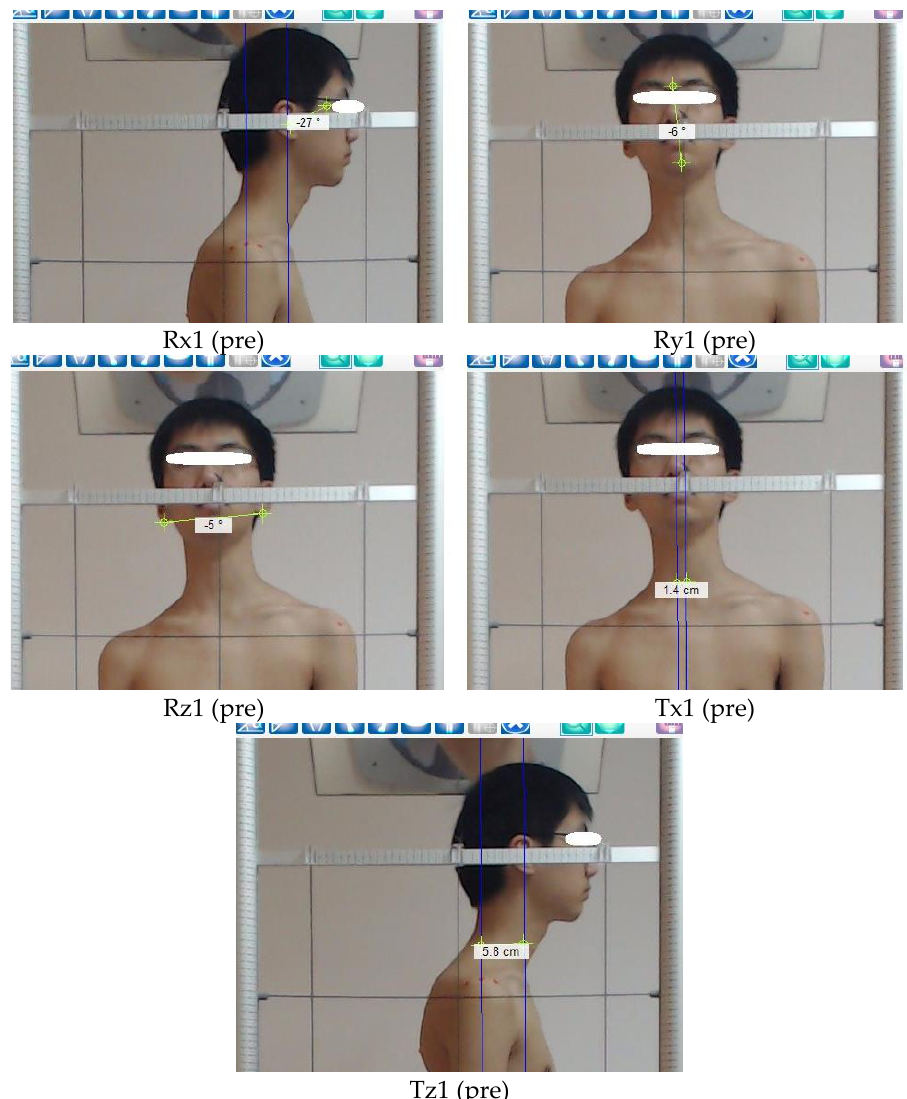
Figure 2. Three-dimensional postural parameters of the head region in relation to the thoracic region. Postural rotations ( Rx , Ry , Rz ). Postural translations ( Tx , Tz ).